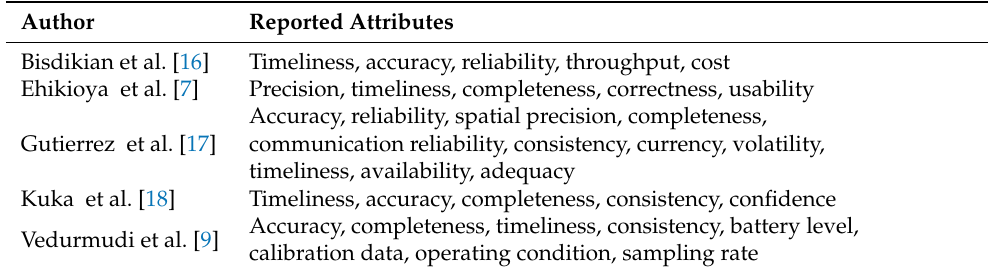
Table 1. Commonly defined data quality attributes. The table is in alphabetical order, sorted by